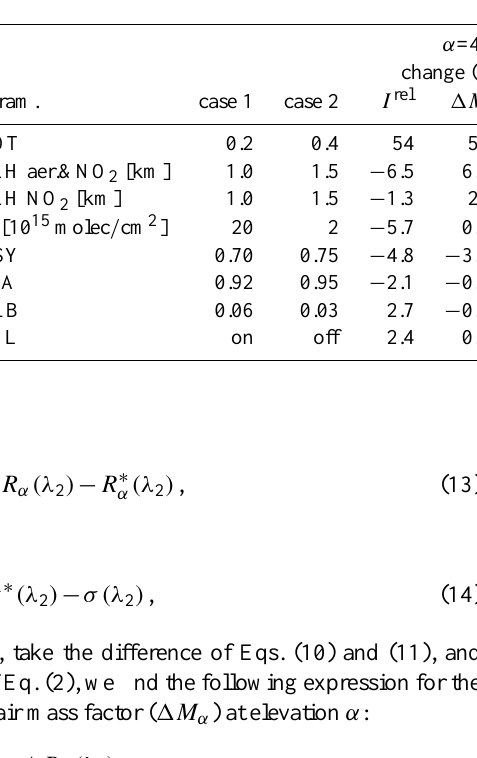
Table 1. Sensitivity study of eight parameters affecting tropospheric NO 2 retrieval: AOT, boundary layer height for NO 2 and aerosols (BLH), boundary layer column of NO 2 (N), asymmetry parameter of aerosols (ASY), single scattering albedo of aerosols (SSA), surface albedo (ALB), and polarization (POL). Each parameter was changed in the DAK model from case 1 (reference value) to case 2, with all other parameters unchanged. For the elevations 4 ◦ , 8 ◦ and 16 ◦ , the effect of this change is given in percent for the relative intensity ( I rel ), the differential air mass factor ( 1M ), and for the tropospheric NO 2 column retrieved by the two-step algorithm ( N Tr ). The percentage was calculated as follows: [ P (case 1)– P (case 2)]/ P (case 2) × 100%, where, for each line, P (case 2) is the model simulation where only the quantity indicated by the first column of that line was changed to case 2, and where all other parameters were as in case 1. The values in the table therefore represent the error made when the ‘true’ atmosphere would be in a state with one specific parameter as in case 2, whereas this and all other parameters are assumed to be as in case 1 (which corresponds to the settings of the look-up tables described in Sect. 3.1.2). Values were calculated for a solar zenith angle of 60 ◦ and a relative azimuth of 180 ◦ .